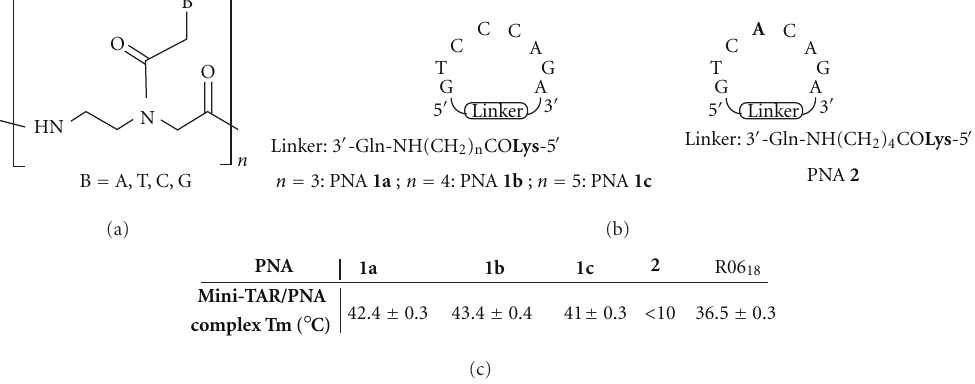
Figure 2: General structures of: (a) PNAs (b) cyclic PNAs 1a–c , 2 ; in bold, mismatched residue; (c) Melting temperatures of cyclic PNAs 1a–c , 2 /TAR and R06 18 aptamer/TAR complexes, obtained from [23].